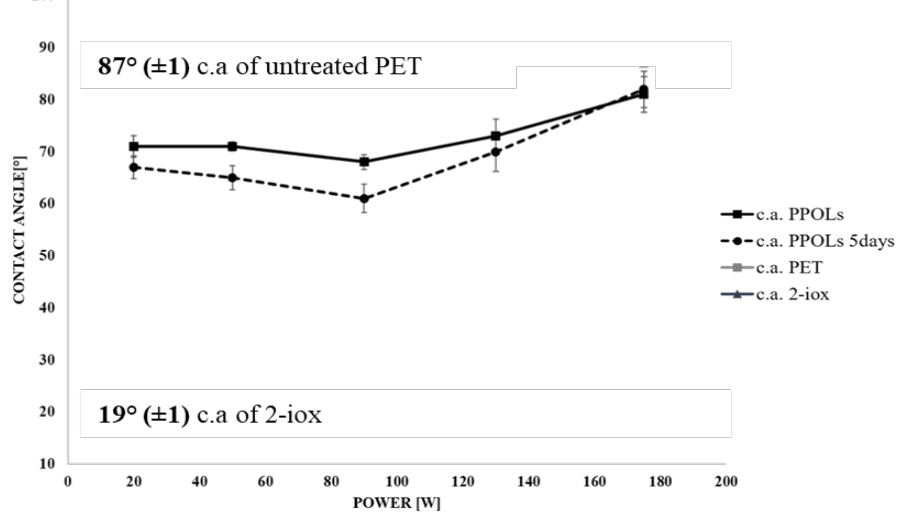
Figure 1. c.a. in the continuous regime at different powers; the values were measured on PET sheets. The values of the contact angle are the average of 5 values collected for each